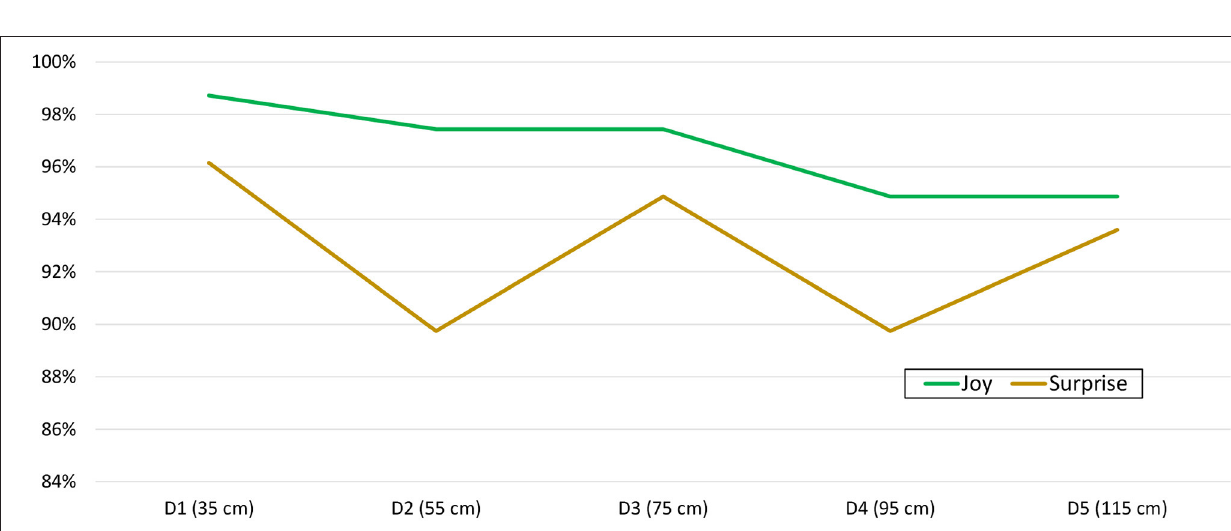
FIGURE 5 | Average successful recognition rate per distance for the positive affect category (Joy and